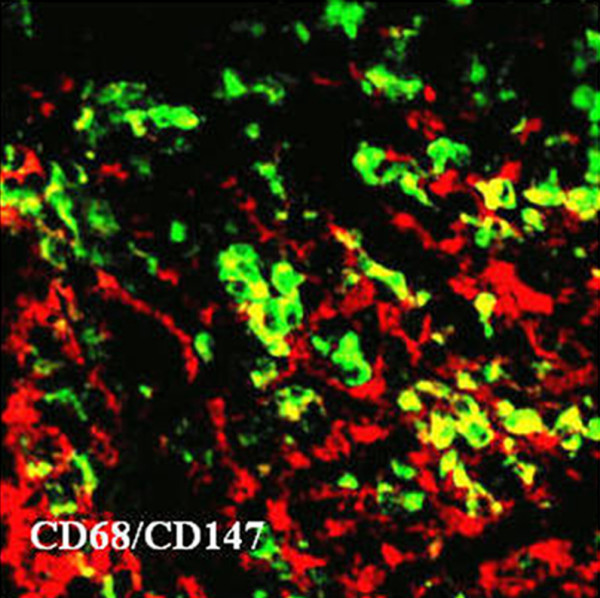
Laser scanning confocal microscope (× 400) image of the double immunofluorescent assay. The expression of CD68+ (green) and CD147+ (red) cells, and the co-expression of CD68+CD147+ cells (yellow) in the lining and sublining layers of rheumatoid arthritis synovium is apparent.